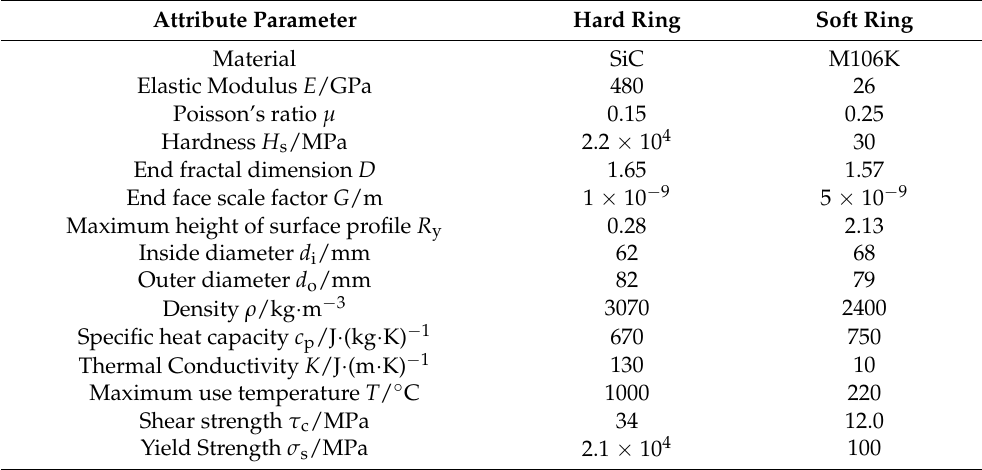
Table 2. Structural parameters and material performance parameters of the rotating and stationary ring.